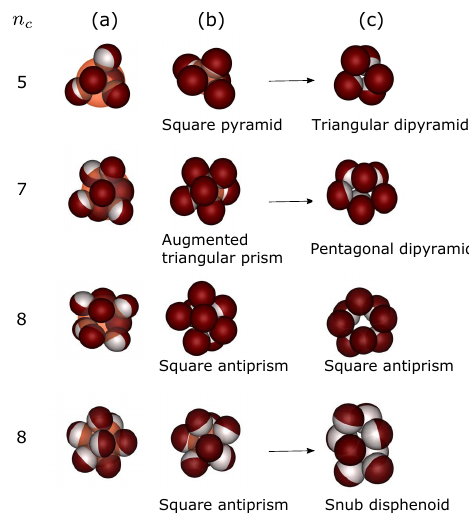
Figure 4. Simulation snapshots of n c -sphere clusters of the packing process. The column ( a ) shows a droplet (shown in pink large sphere) and single-patch colloids trapped at its surface after 3.5 cycles. After 4.5 10 5 MC cycles (column ( b )), the droplet has shrunk and the colloids have packed into × a well-defined structure. In the final stage of the simulations (column ( c )), some clusters are rearranged to form M 2 -minimal clusters. The arrows refer to the structures that are rearranged during evaporation. The first rows are the results in the case of χ = 0.25, and the last row is for χ = 0.5.